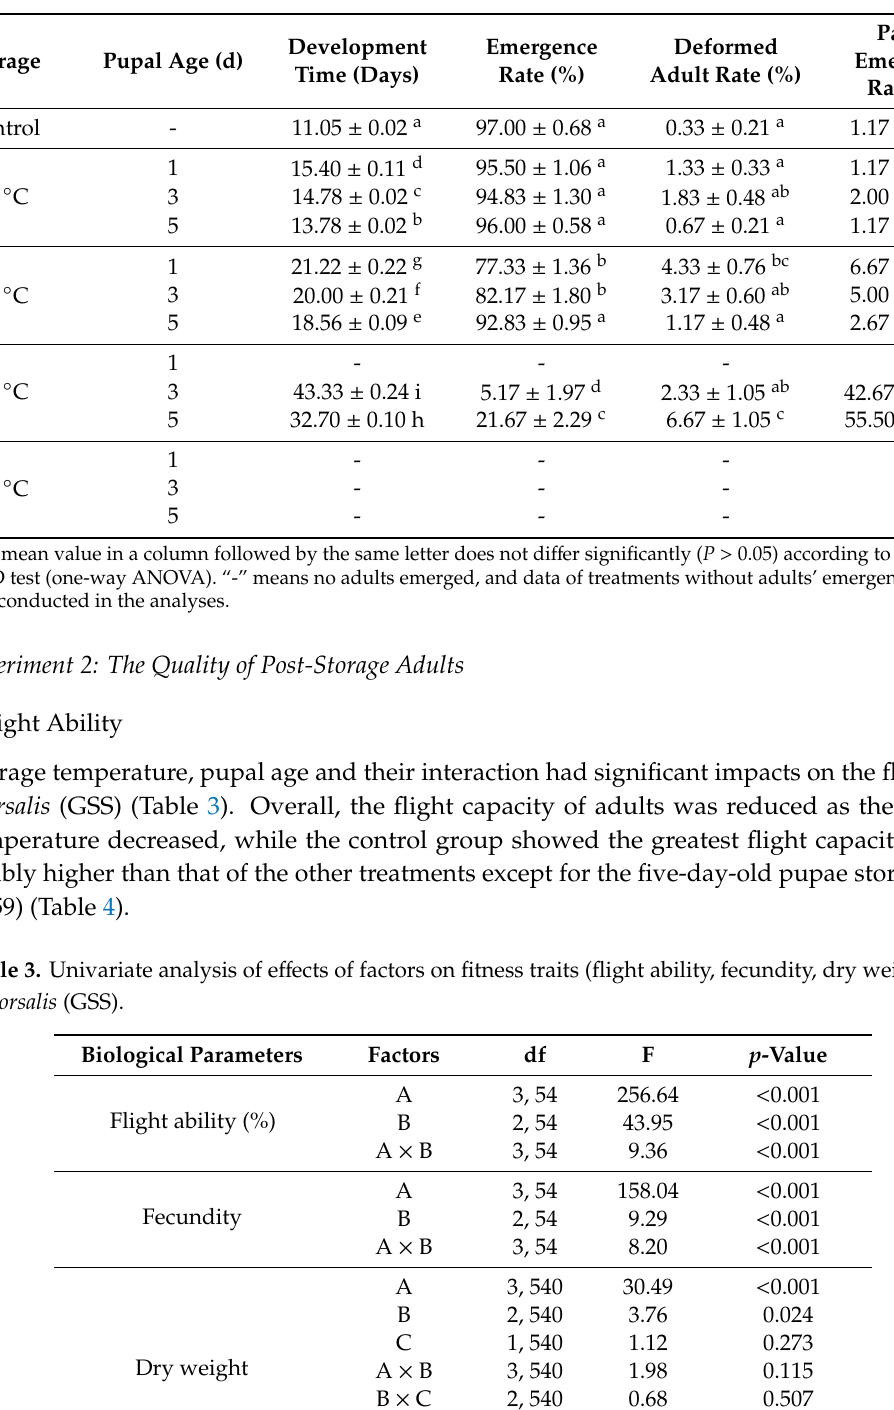
Table 2. Mean ± SE of pupal development time, emergence rate, adult morphological normality rate, deformed adult rate and partial emergence rate of B. dorsalis (GSS) pupae (1 d old, 3 d old and 5 d old) stored at temperature of 10, 13, 16 and 19 ◦ C. Storage Pupal Age (d)